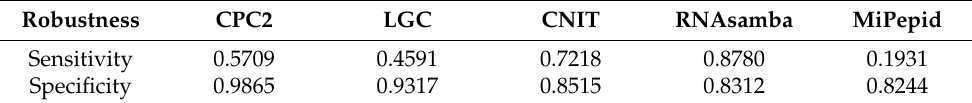
Table 2. Sensitivity and specificity of the computational tools